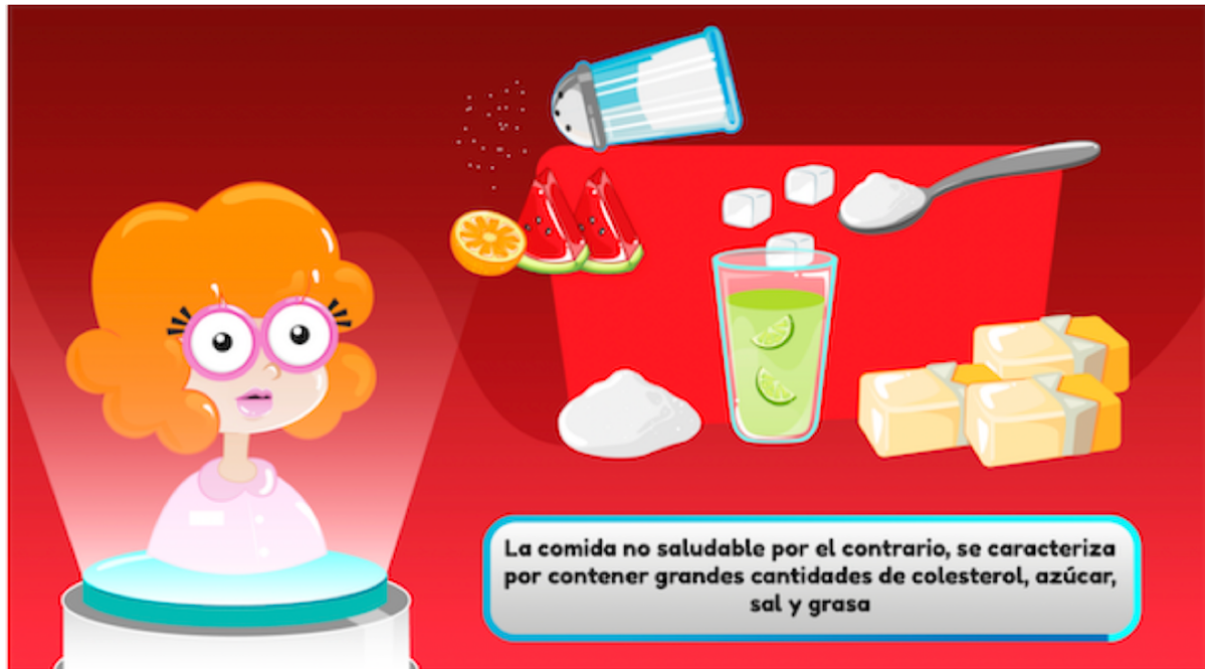
Figure 5. FoodRateMaster explanation of unhealthy